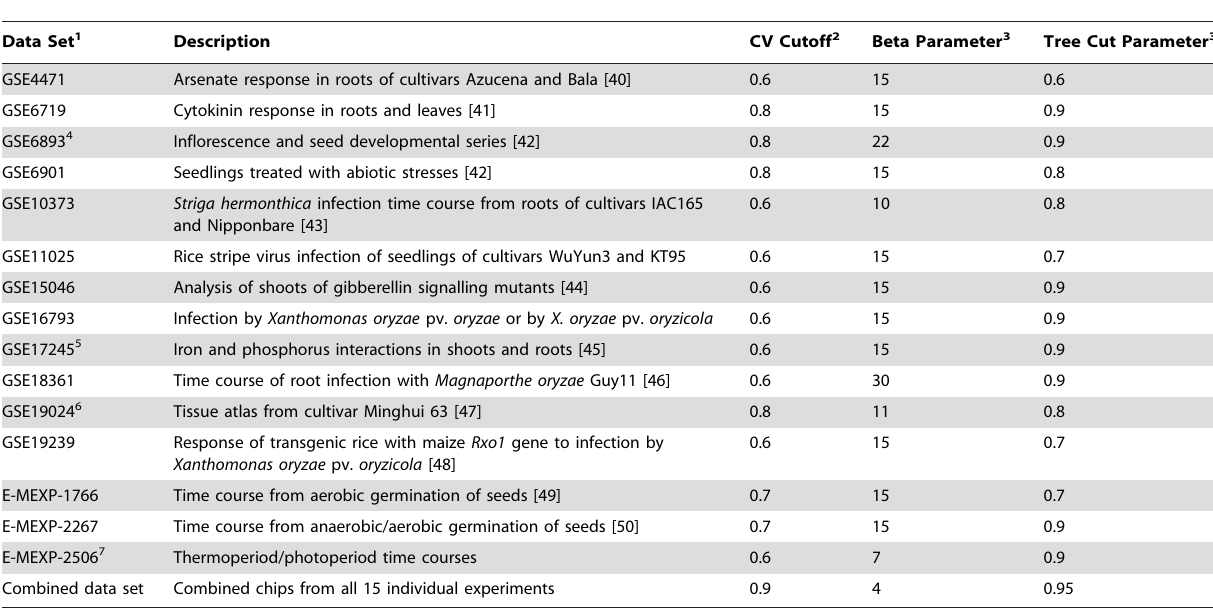
Table 1. Rice gene expression data sets and analysis parameters used in this